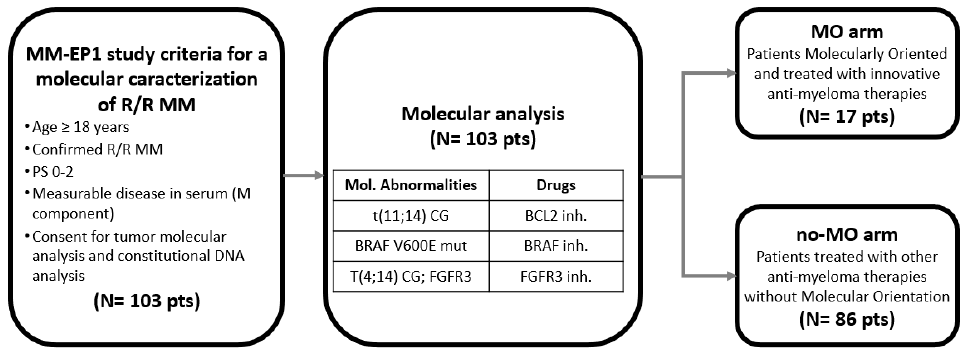
Figure 1. Flow chart of the MM-EP1 study. The treatment algorithm for precision medicine was based on molecular abnormalities: t(11;14) chromosomal translocation therapeutically targeted by a BCL2 inhibitor; t(4;14) chromosomal translocation with fusion/FGFR3 rearrangement targeted by a FGFR3 inhibitor; and the BRAF V600E mutation targeted by a BRAF inhibitor. r/r MM: relapsed/refractory multiple myeloma, PS: performance status, MO: molecularly oriented, no-MO: no molecularly oriented.